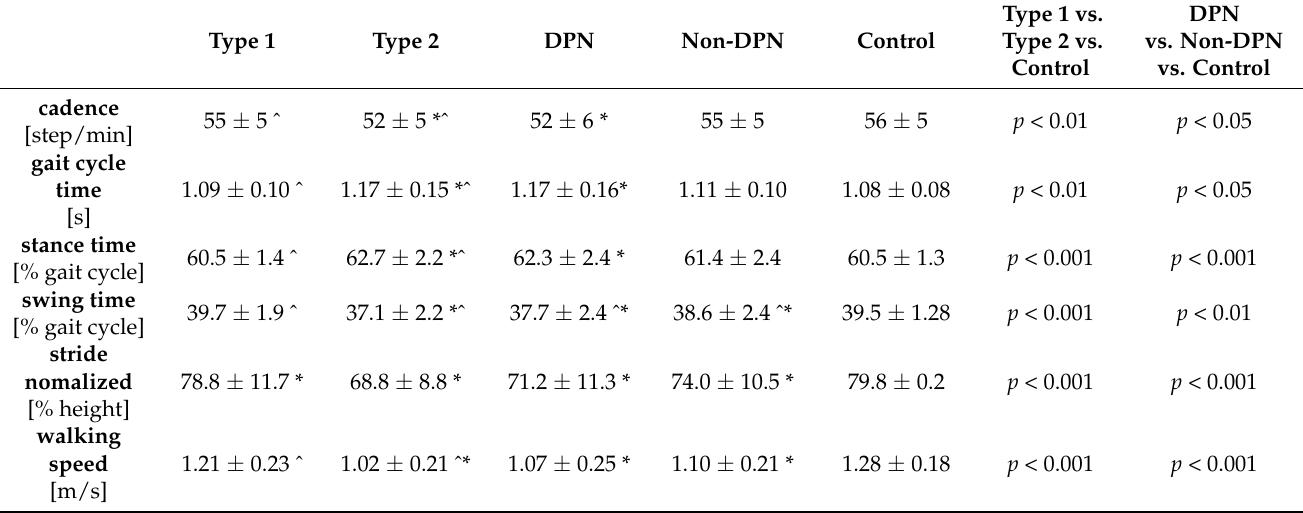
Table 2. Spatio-temporal parameters in type 1, type 2, neuropathic (DPN), non-neuropathic (non-DPN) and control groups. Mean ( ± std) of each parameter are reported for each group. Kruskal–Wallis statistical differences are shown in the last two columns. * denotes post hoc pairwise statistically significant difference between any diabetic group and control ( p < 0.05); ˆ denotes post hoc pairwise statistically significant difference between two diabetic groups ( p <